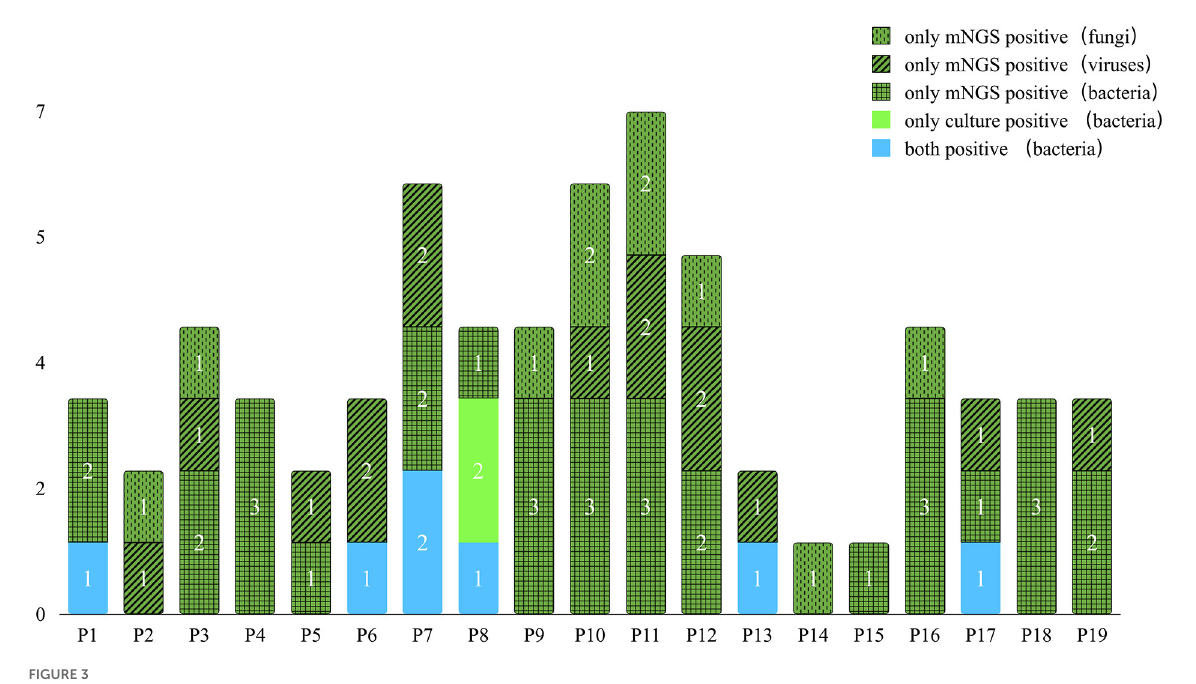
FIGURE3 The distribution of pathogens compared by mNGS and urine culture.